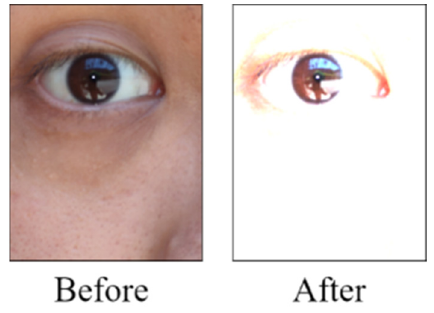
Figure 9. Eye image obtained after increasing the exposure.